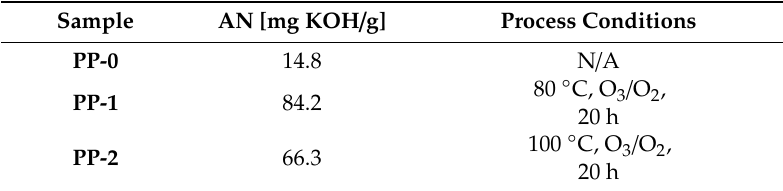
Table 1. Acid number (AN) and conditions used for the thermal degradation of PP-0 to 2.